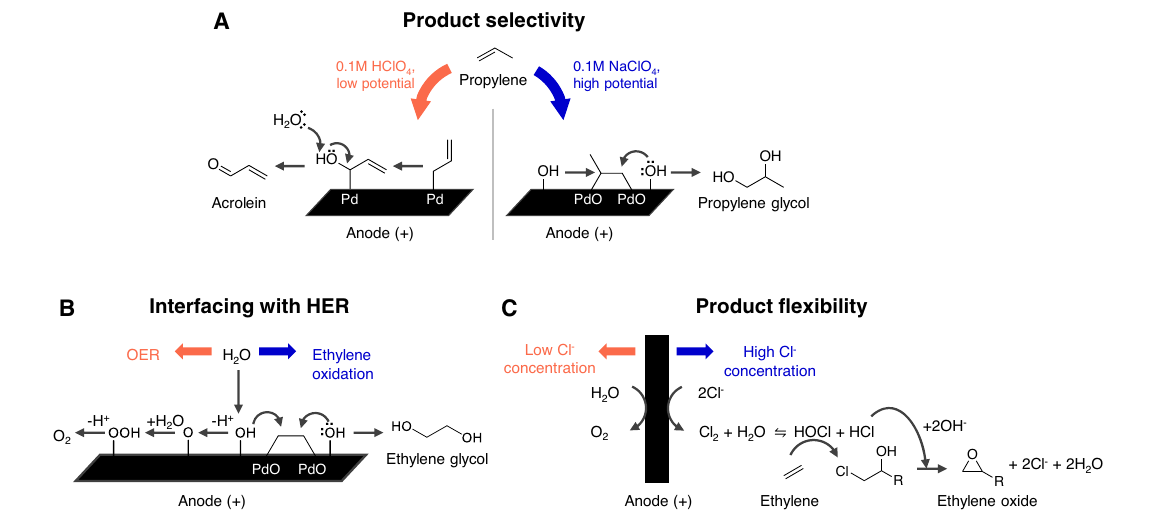
Fig. 4 | Technical targets that must be achieved for anodic hydrocarbon oxi- dations and reported strategies to overcome them. A Funnelling selectivity towardsthedesiredproduct(adaptedfromref.24,copyright2019RoyalSocietyof Chemistry). B The interfacing of anodic partial hydrocarbon oxidation with